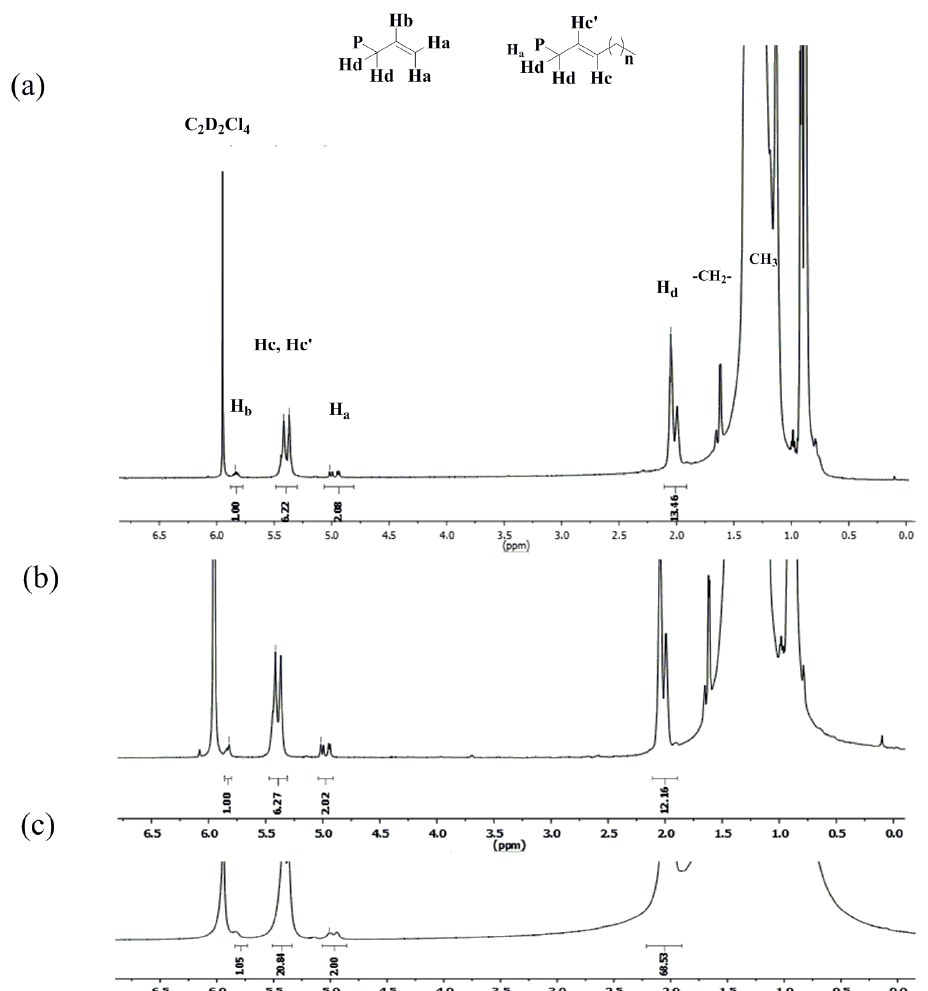
Figure 8. 1 H NMR spectra of the PE samples produced using Ni1 /EtAlCl 2 at ( a ) 20 o C, ( b ) 30 o C and ( c ) 50 °C (runs 7, 4 and 9, Table 3); recorded at 100 °C in d -C 2 D 2 Cl 4 . In the 13 C NMR spectrum of the PE produced using Ni1 /EtAlCl 2 at 20 °C (run 7, Table 3), characteristic resonances for the alkenic-carbons for the vinyl and vinylene functional groups, denoted C a , C b , C c and C c’, were seen in the downfield region (see inset in Figure S5). In the upfield region (main spectrum in Figure 9), peaks for the (–CH 2 –) repeat unit along with less intense resonances corresponding to the various types of branch can be seen. Using approaches described in the literature [56–58], the assignment and relative percentage of each branch along with the branching density can be determined. Specifi- cally, the analysis of this sample revealed 67 branches/1000 Cs, including methyl (76.3%), ethyl (1.6%), propyl (2.3%), butyl (4.8%), 1,4-paired methyl (2.5%), 1,6-paired methyl (2.9%) and longer chain branches (9.3%) (see Figure S5). By comparison, for the PE sample generated at 30 °C (run 4, Table 3), the number of branches increased to 91/1000 Cs, which included methyl (70.4%), ethyl (2.0%), propyl (2.9%), butyl (2.2%), 1,4-paired methyl (7.6%), 1,6-paired methyl (4.2%) and longer chain branches (10.3%) (see inset in Figure 9). This higher branching density was supported by a lower T m value for this PE sample; similar results have been reported in the literature [23,59–61]. Conversely, the 13 C NMR spectrum of the PE generated at 50 °C (run 8, Table 3) showed the branching density increased to 135/1000 Cs and was based on methyl (25.8%), ethyl (4.8%), propyl (3.4%), butyl (8.1%), amyl (6.0%), 1,4-paired methyl (15.9%), 1,5-paired methyl (4.1%), 1,6-paired methyl (21.4%) and longer chain branches (10.1%) (see Figure S6).